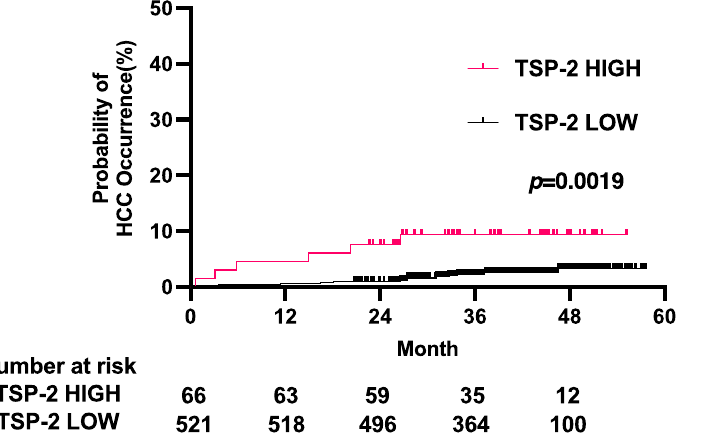
Figure 5. The serum TSP-2 level identifies patients with a high risk of HCC occurrence among pa- patients with a FIB-4 index < 3.25. Kaplan–Meier curves for the occurrence of HCC in patients with a tients with a FIB-4 index < 3.25. Kaplan‒Meier curves for the occurrence of HCC in patients with a FIB-4 index less than 3.25 among all the cohorts stratified by serum TSP-2 FIB-4 index less than 3.25 among all the cohorts stratified by serum TSP-2 levels.